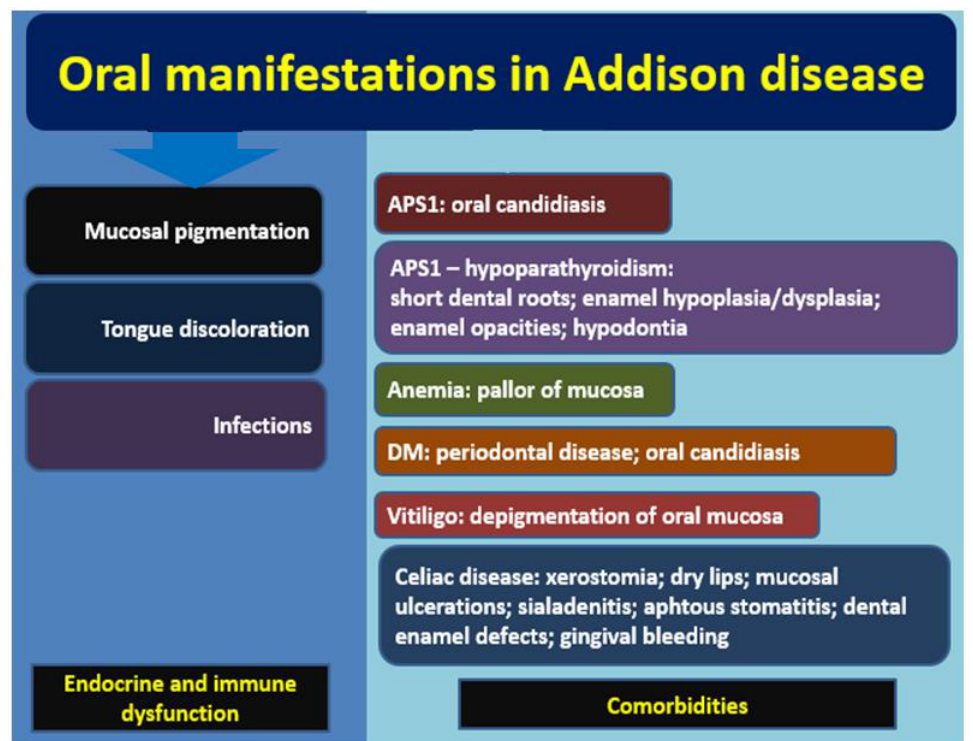
Figure 1. Overview of the main oral manifestations in Addison disease, either related to endocrine and immune dysfunction accompanying the disease itself (left side) or associated with a heterogeneous panel of comorbidities based on a common genetic or autoimmune background as seen in APS1, anemia, DM, vitiligo, and celiac disease (right side) (abbreviations: APS = autoimmune polyglandular syndrome; DM = diabetes mellitus) (see references in text).